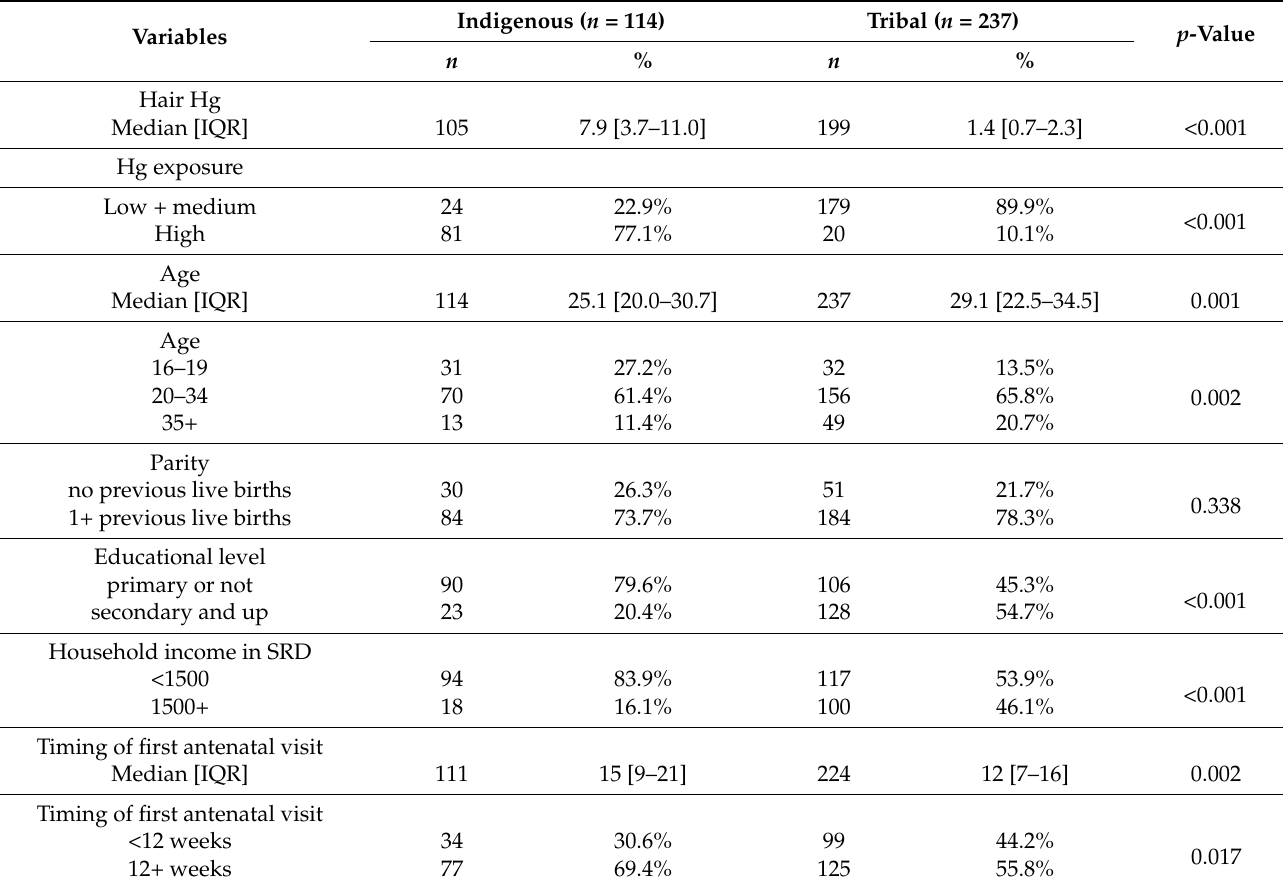
Table 1. Characteristics of the Indigenous and Tribal study participants.